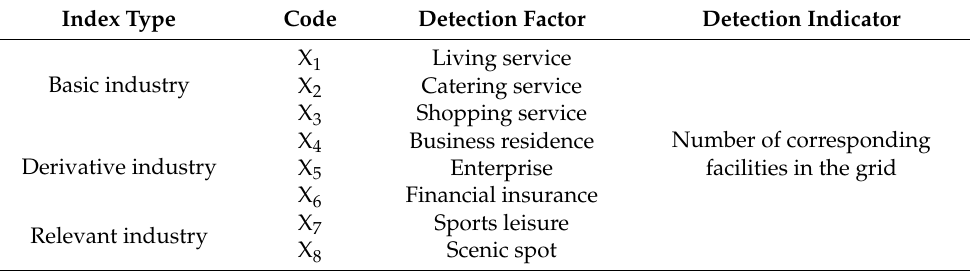
Table 3. Index system of driving factors.